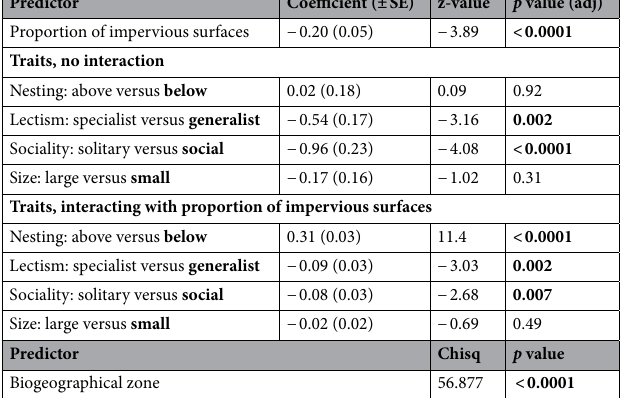
Table 4. Summary of the traits-impervious surfaces model. p values in bold are significant (α = 5%). The significance of the categorical variable “Biogeographical zone” was evaluated using a Likelihood Ratio Test. This model is a mixed-effect model, the random variables included are the sites ID, nested in the sampling categories, as well as the species names. Coefficients are given with their standard error. Traits in bold are the reference modalities. p value(adj) means that p-values were adjusted with the False Discovery Rate adjustment